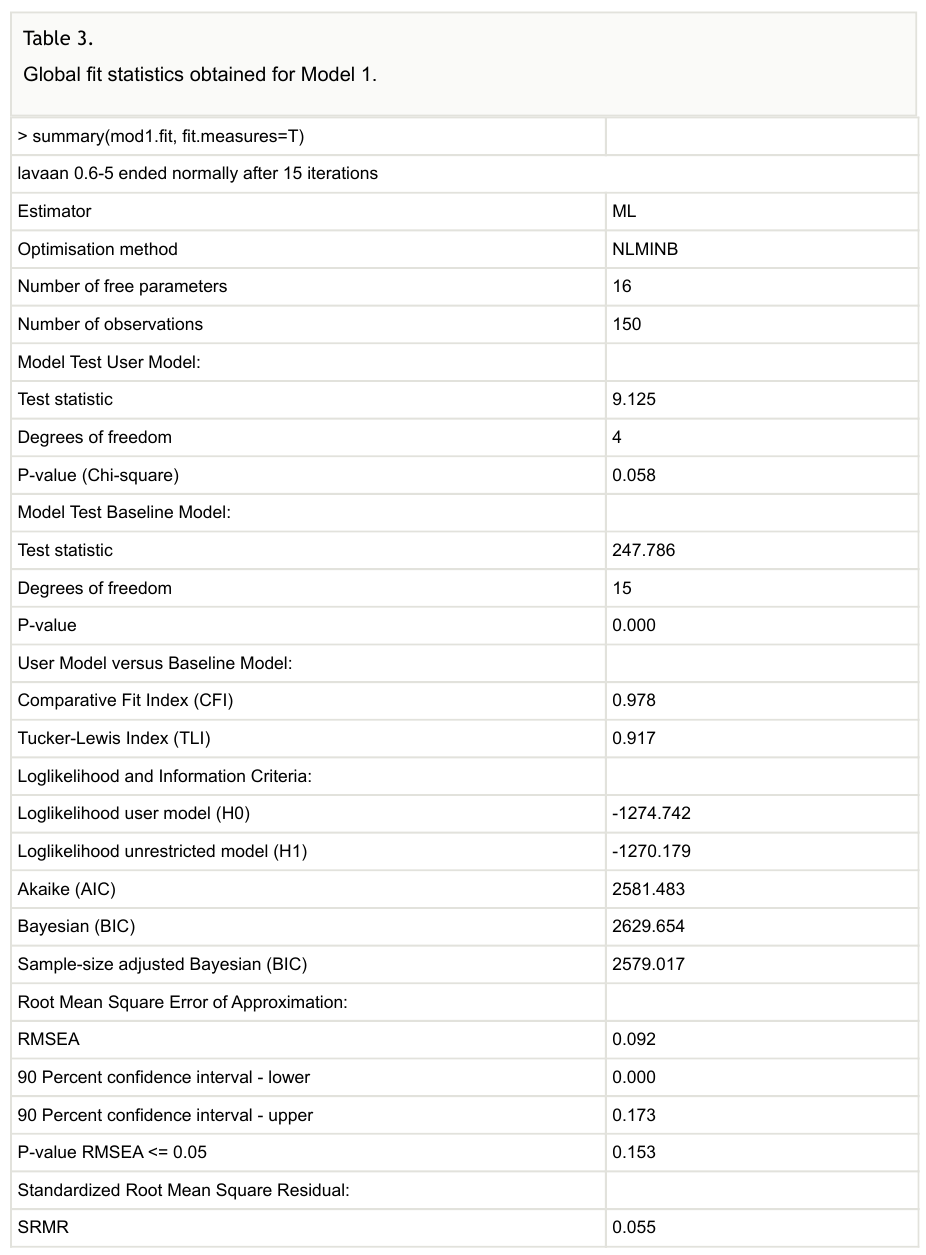
Table 3. Global fit statistics obtained for Model